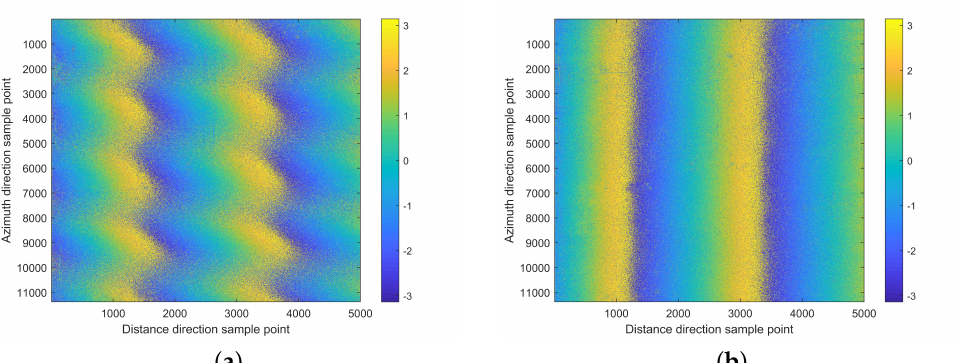
Figure 17. The comparison of interference fringe results. ( a ) The comparison method; ( b ) the proposed